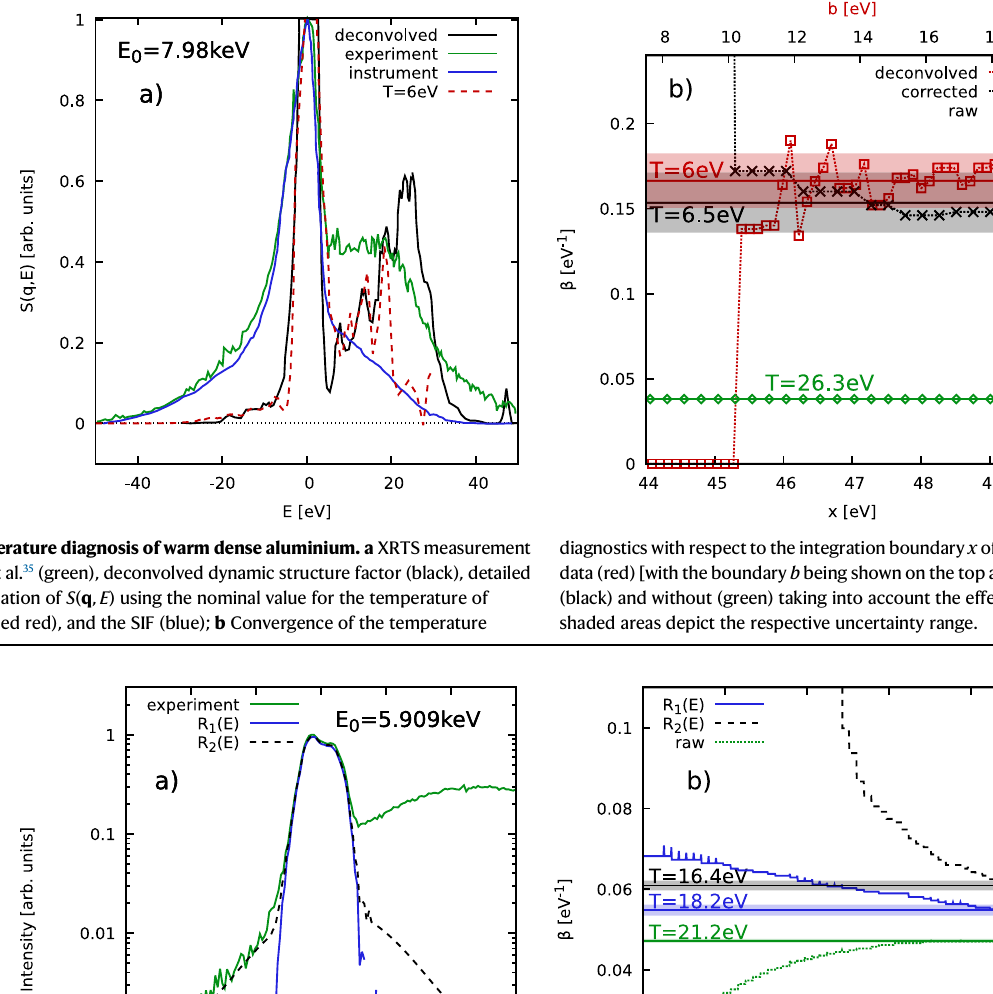
diagnosis with respect to the integration boundary x with (blue and black) and without(green)takingintoaccountanySIF.Theshadedareasdepicttherespective uncertainty